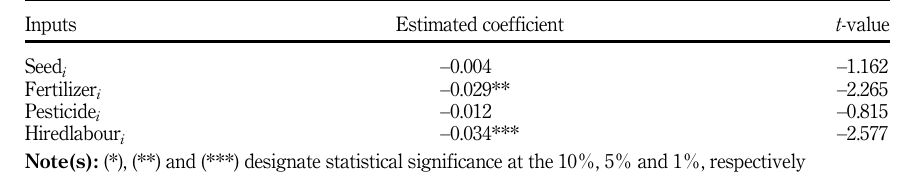
rationing on the amount of capital allocated to